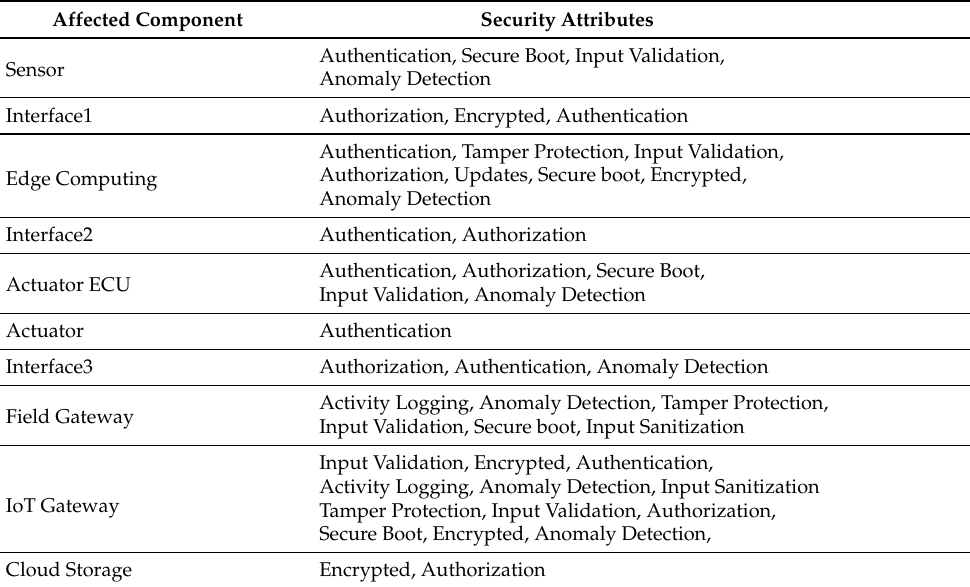
Table 4. Summary of all affected system components and related violated security